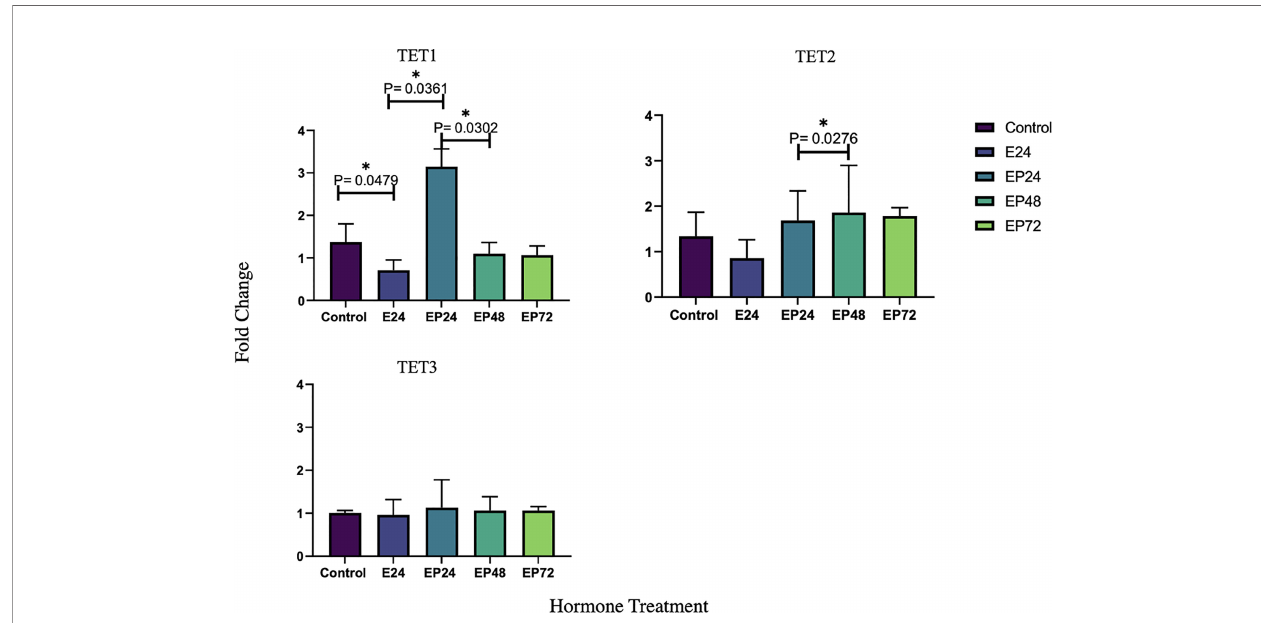
FIGURE 1 | Relative TET1 TET2 and TET3 mRNA expression in response to steroid hormone treatment in AN3 cells. The y-axis shows the fold change of mRNA levels following different treatments compared with control, all results corrected against geo-mean expressions of three reference genes - YWHAZ, RPLO and RPL13a. The x-axis shows different treatment groups. E24 = 24h Estrogen; EP24, EP48 and EP72 = both Estrogen + Progesterone for 24, 48 and 72h. Data are presented as mean ± SEM *p < 0.05. P ≤ 0.1 was considered as approaching signi fi cance. The experimental setup included three independent sets of cell culture experiments (n = 3) and triplicates of each sample for the